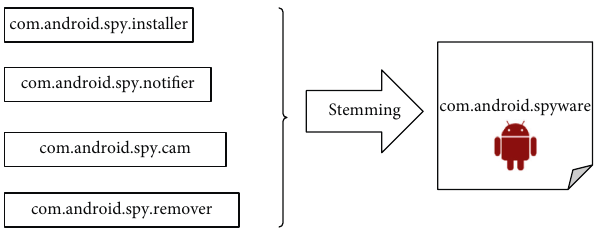
Figure 14: Stemming